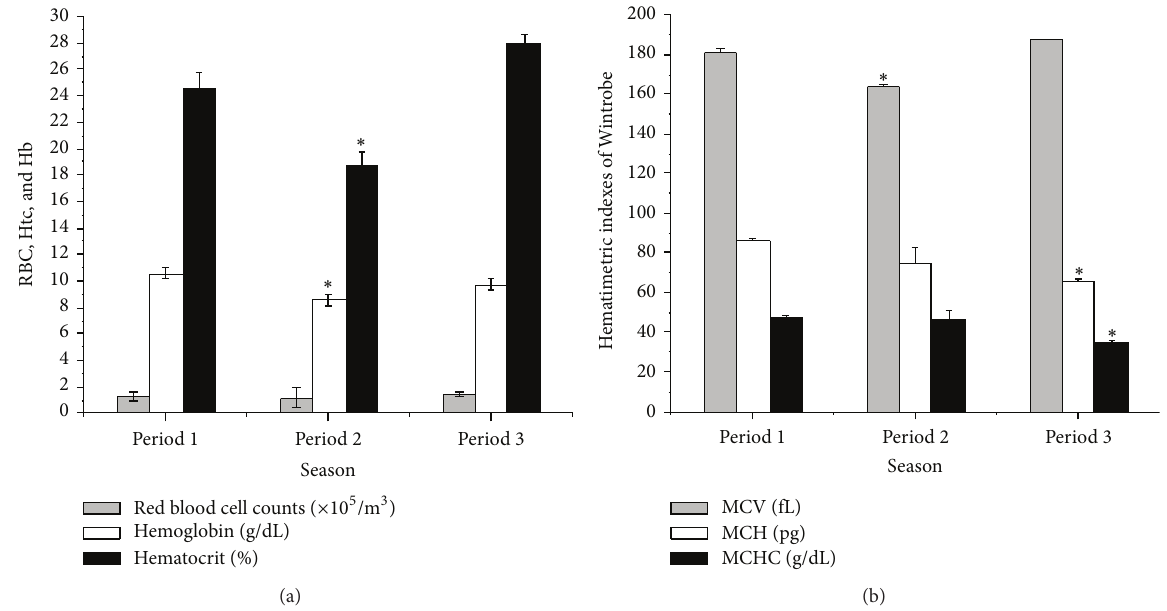
Figure 3: Variations in serum of A. gigas in Period 1 (9.99 mm 3 , 26.14 ∘ C), Period 2 (2.74 mm 3 , 25.46 ∘ C), and Period 3 (5.8 mm 3 , 26.94 ∘ C) to RBC: red blood cell counts, Hb: hemoglobin, and Htc: hematocrit (a); hematimetric indexes of Wintrobe—MVC, MCH, and MCHC (b). ( ∗ ) Significant ( 𝑃 < 0.05 ).